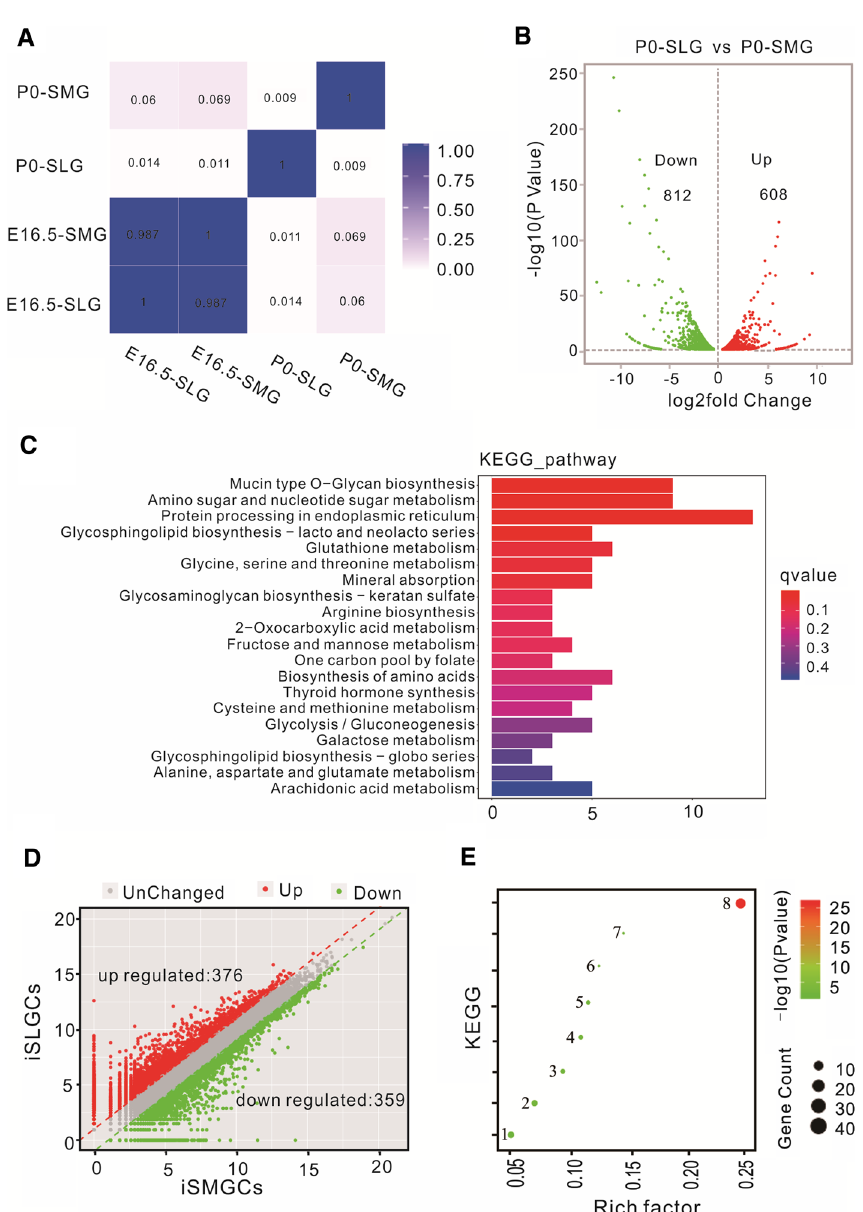
Fig. 5 Differentially expressed gene analysis (DEG) and KEGG enrichment by RNA-seq. A Correlation heatmap showing correlation between SLG and SMG on E16.5 and P0. B In total, 608 upregulated (red dots) and 812 downregulated (green dots) DEGs with P < 0.001 were counted between SLG and SMG. C The top 20 KEGG pathways between SLG and SMG on P0 are listed. D RNA-seq analysis revealed upregulated (376) and downregulated (359) DEGs in iSMGCs, compared with in iSLGCs. E KEGG enrichment included eight signaling pathways based on the DEGs between iSMGCs and iSLGCs: 1–8 represent cytokine–cytokine